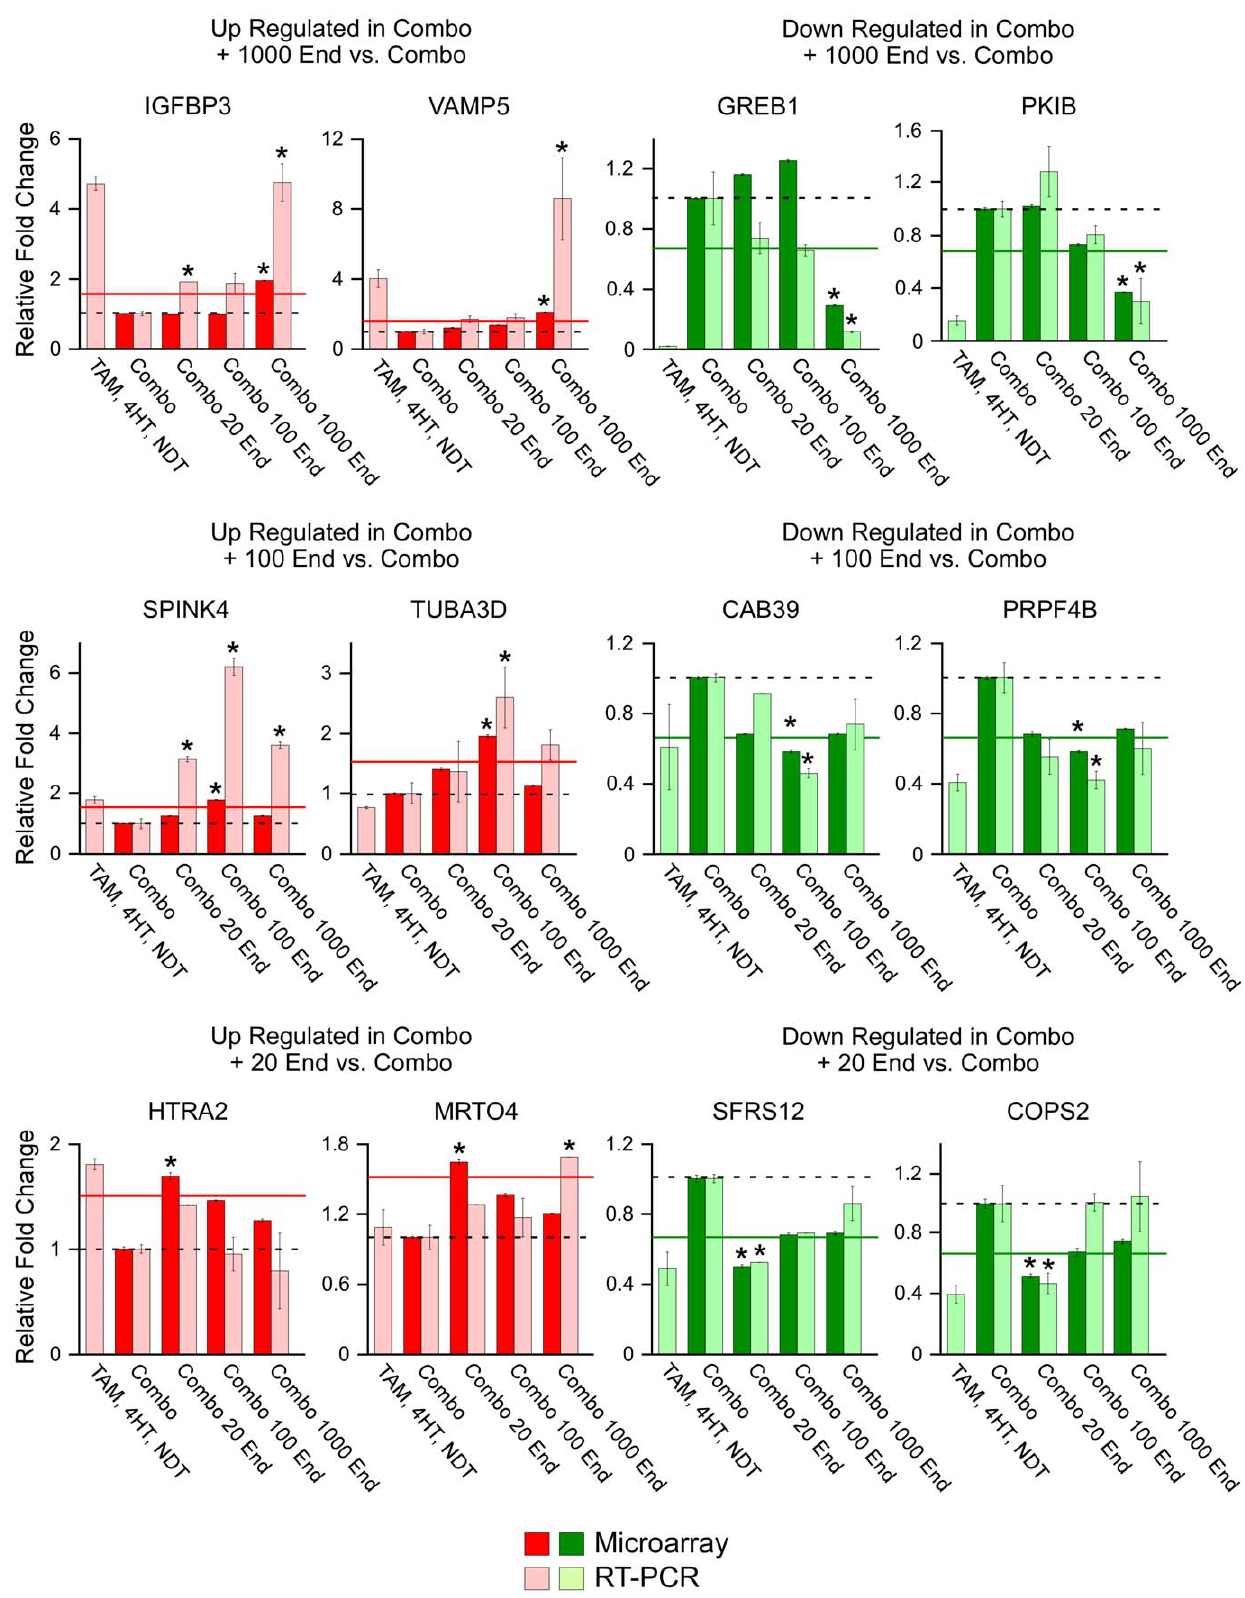
Figure 7. Real-time PCR confirmation of randomly selected genes whose expression levels were either increased (red) or decreased (green) by a specific endoxifen concentration. Genes whose expression levels were determined to be specifically increased (red) or decreased (green) by only one of the three endoxifen concentrations were randomly selected for confirmation of the microarray data. Darkly shaded bars depict